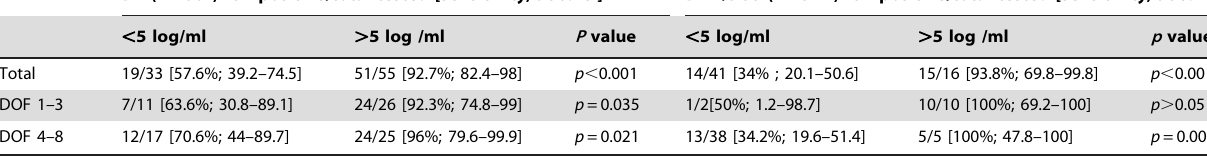
DF (n=88*)NS1 positive/total tested [sensitivity; 95%